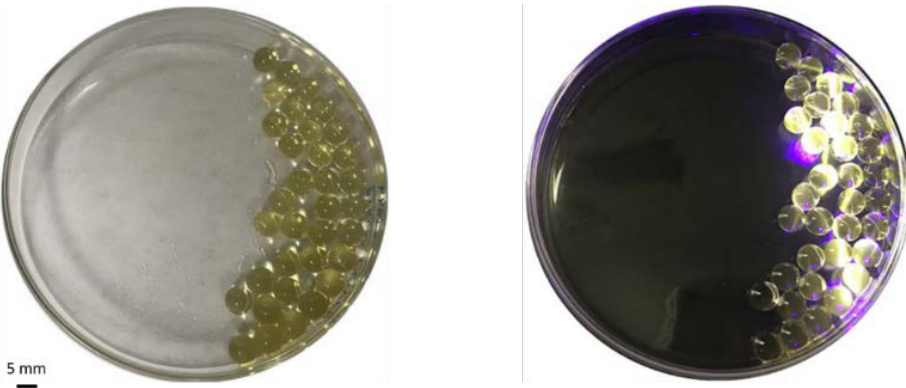
Figure 5. O-CDs embedded in sodium polyacrylate (SPA)-based beads under ( left ) regular light and ( right ) UV light.